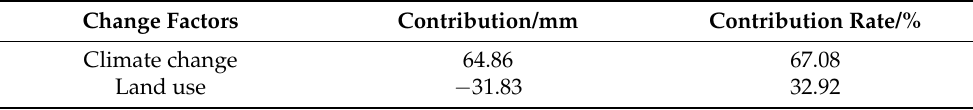
Table 10. Attribution Analysis of Water yield in the XRB.